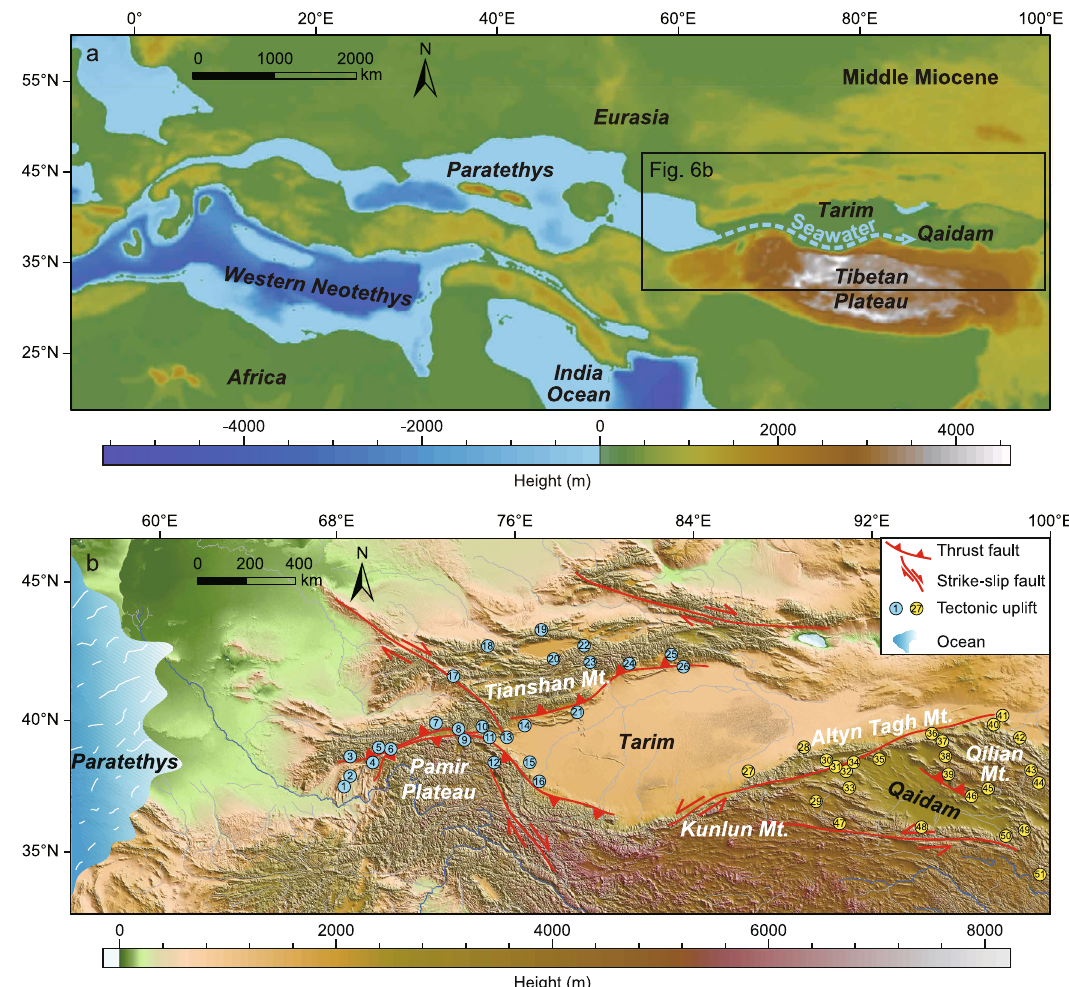
Fig. 4 Hypothesized path of the seawater incursion and reactivated tectonic events during the mid-Miocene. a Hypothesized path of the seawater incursion from the Paratethyan Sea to the Qaidam Basin during the mid-Miocene. The blue dash line indicates a possible incursion path, a paleoriver along the southern Tarim Basin identi fi ed previously 34 . The paleogeographic map modi fi ed from ref. 65 . b Reactivated tectonic events at the Pamir-Tian Shan region and northern Tibetan Plateau around the mid-Miocene and afterwards. Blue and yellow dots indicate summarized tectonic events since the mid- Miocene at the Pamir-Tian Shan region and northern Tibetan Plateau respectively. The eastern boundary of the Paratethys around the mid-Miocene follows ref. 66 . Data sources are provided in Supplementary Note 5 and Supplementary